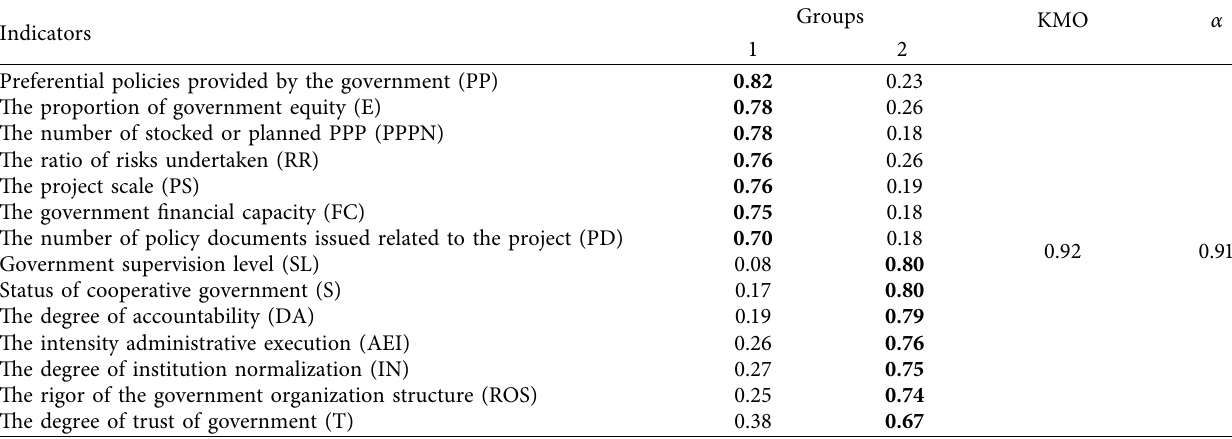
Table 2: Reliability and validity test.